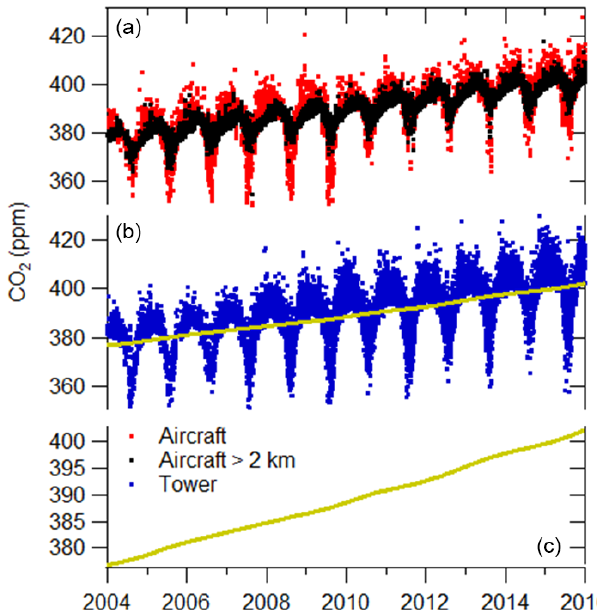
Figure 3. CO 2 observations from aircraft (a) and towers (b) . The yellow line in panel (b) illustrates the deseasonalized trend at the Mauna Loa Observatory (MLO), the same as in (c) , in which the y axis is